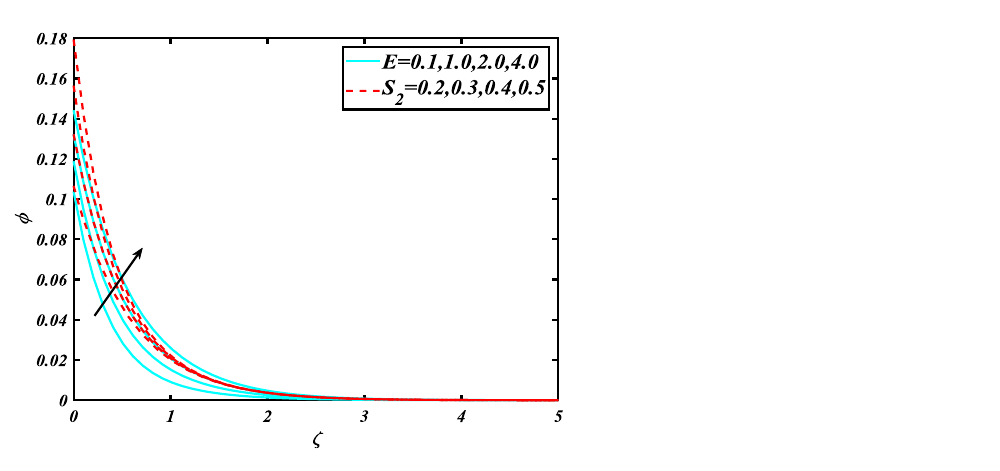
Figure 10. Significance of E & S 2 for φ